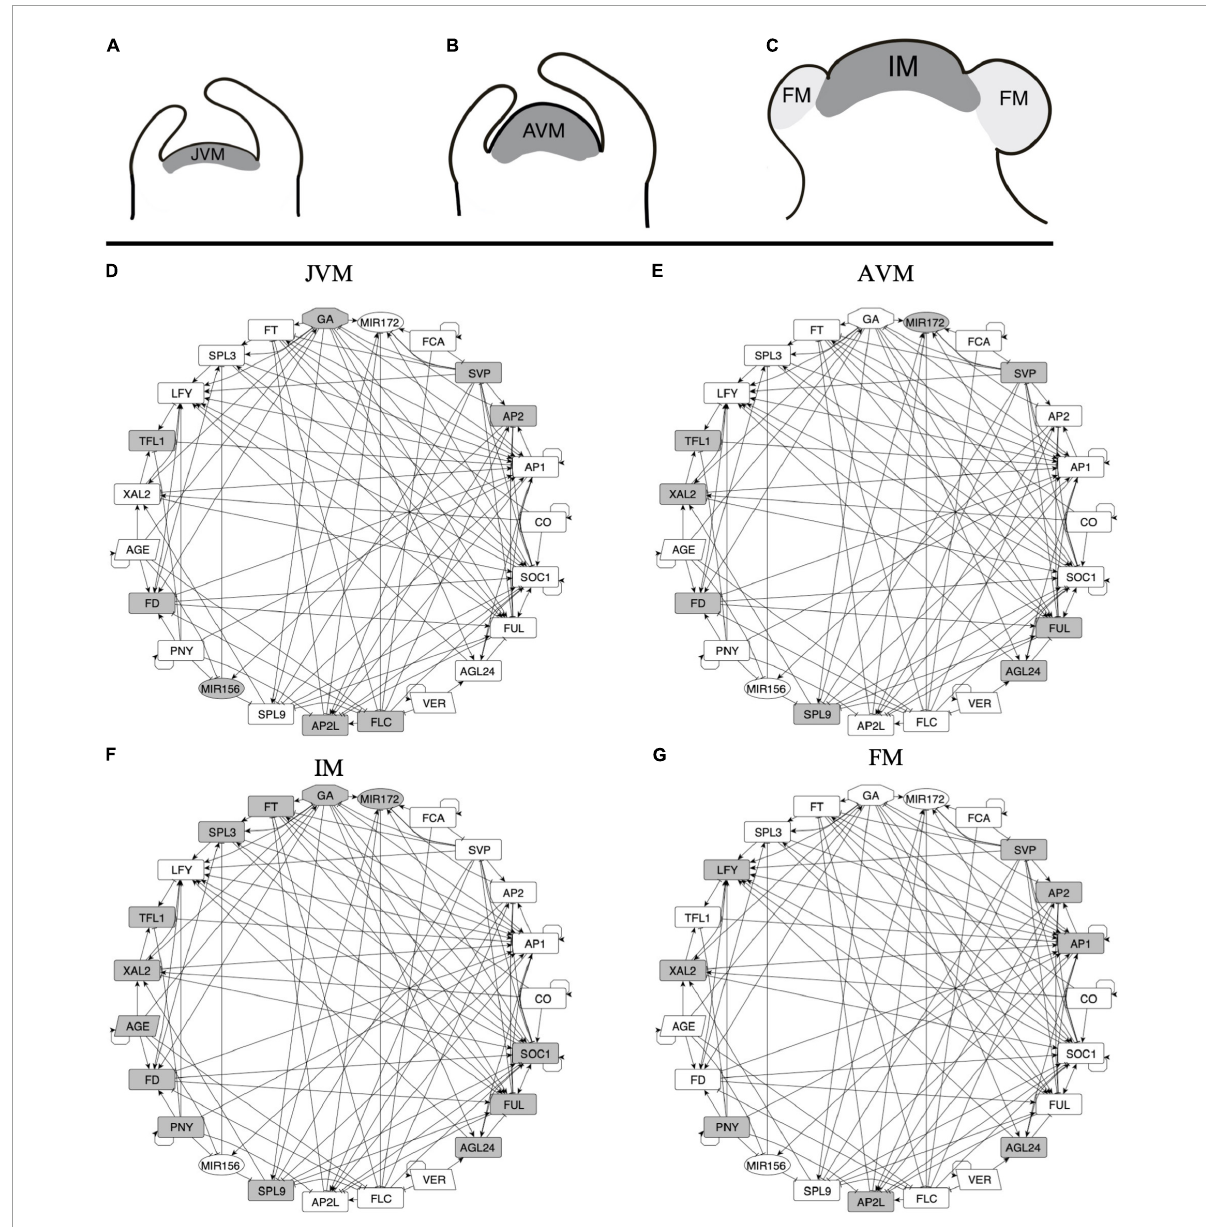
FIGURE3 A multi-stable dynamic GRN model underlies the different expression patterns observed during SAM development and FM induction. (A–C) Three stages of the SAM can be distinguished during development after germination: the juvenile vegetative meristem (JVM), the adult vegetative meristem (AVM), and the inflorescence meristem (IM). During the vegetative phase of development, the SAM produces leaves, while at the reproductive state, the floral meristems (FM) are formed at the flanks of the IM. (D–G) A dynamic , multi-stable gene regulatory network underlies the development of the different types of meristems. Nodes in gray are the ones expected to be express in each meristem stage. Positive (arrows) and negative (T-shape lines) interactions are